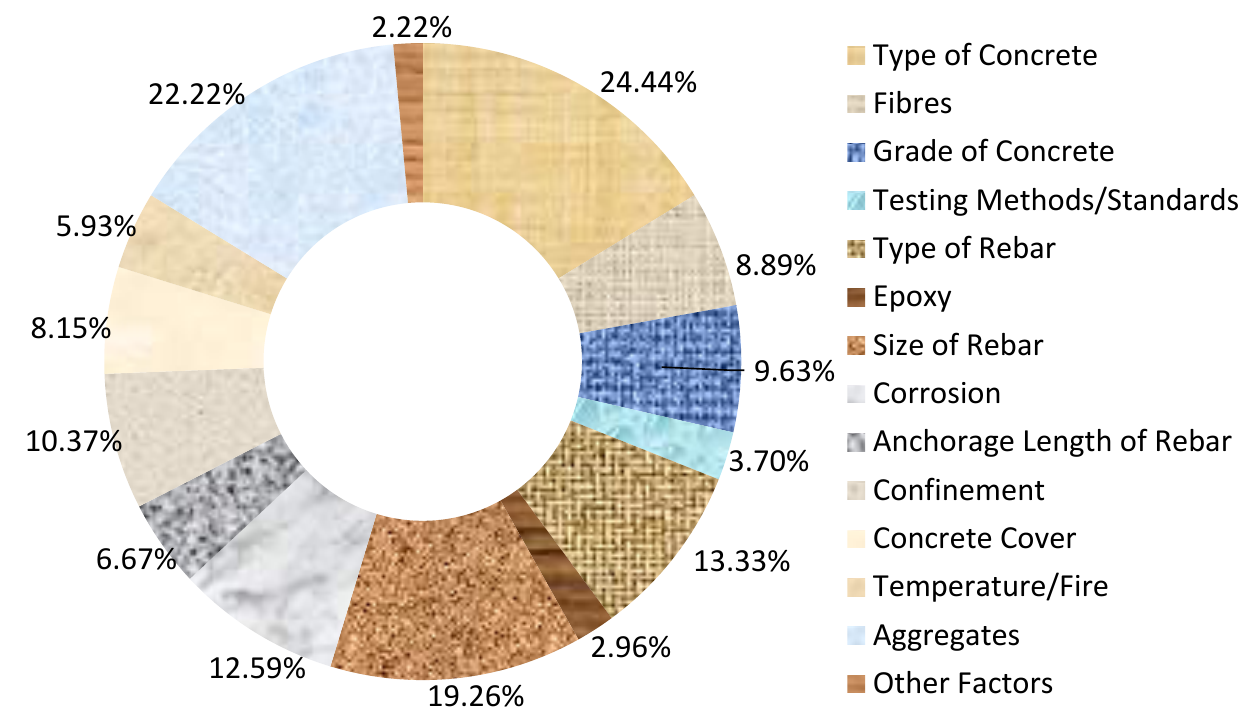
Table 3. Comparing bond strength discussed in the literature.